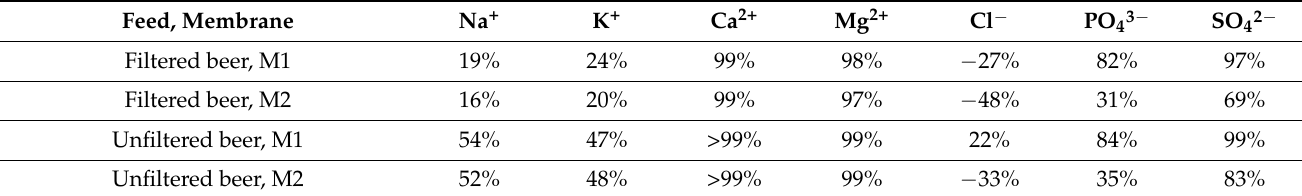
Table 3. Salt rejections at the end of the dealcoholization